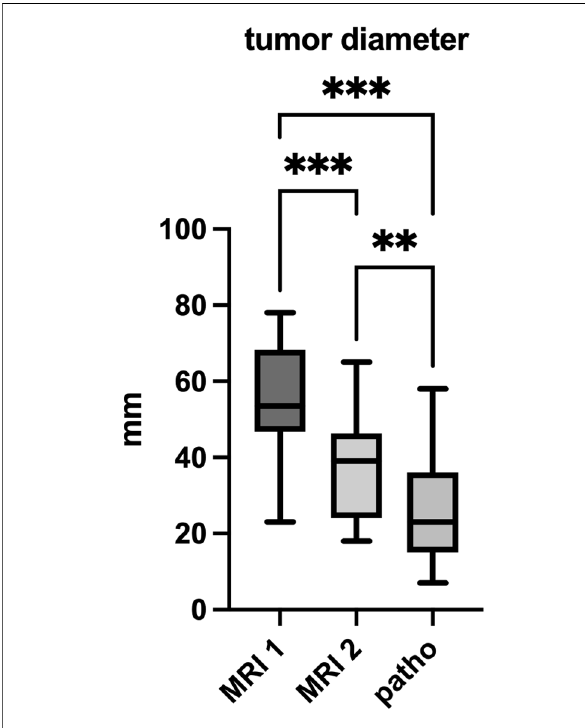
FIGURE 3 Tumor volume in cm3 measured in primary- and re-staging MRI. *** signi fi cance level α